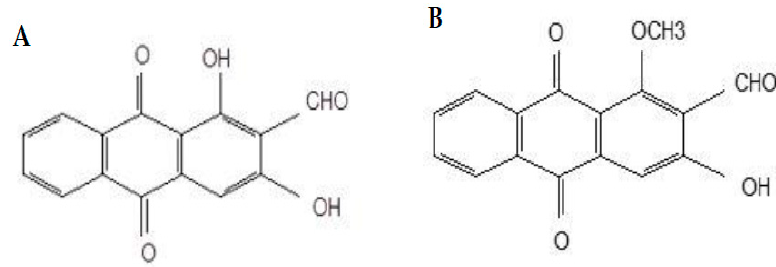
Figure 1. Chemical structures of nordamnacanthal ( A ) and damnacanthal ( B ).